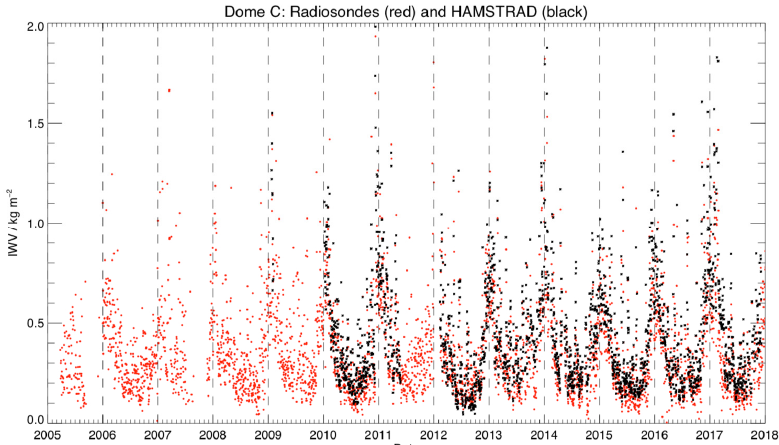
Figure 1. Time evolution of daily-averaged IWV (kg m − 2 ) measured at Dome C from 2005 to 2017 by the radiosondes (red filled circles) and from 2009 to 2017 by H 2 O Antarctica Microwave Stratospheric and Tropospheric Radiometers (HAMSTRAD) (black stars).